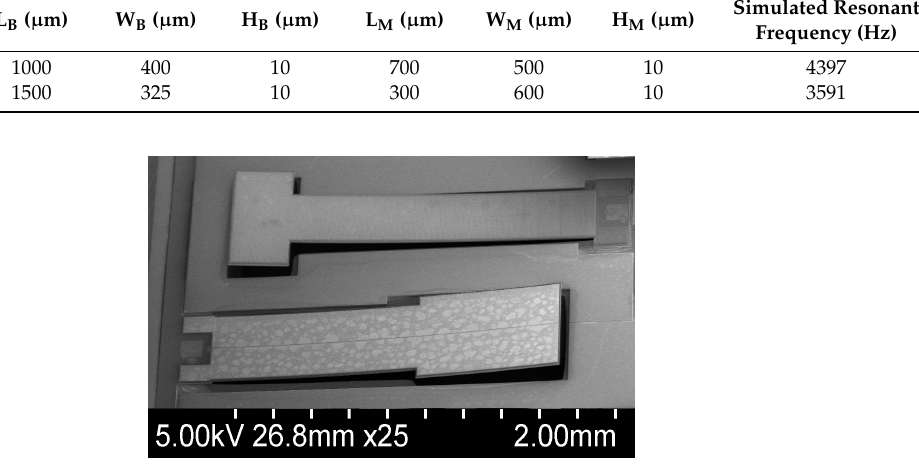
Figure 11. SEM micrograph of the fabricated harvesters Design 1 (bottom) and Design 2 (top).